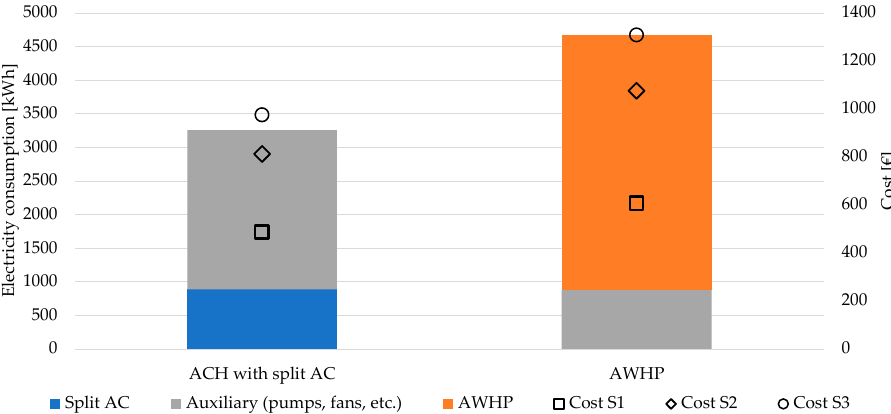
Figure 11. Annual electricity consumption (bars) and energy costs (markers) in three scenarios of energy prices for ACH with split AC and AWHP in the cooling regime.